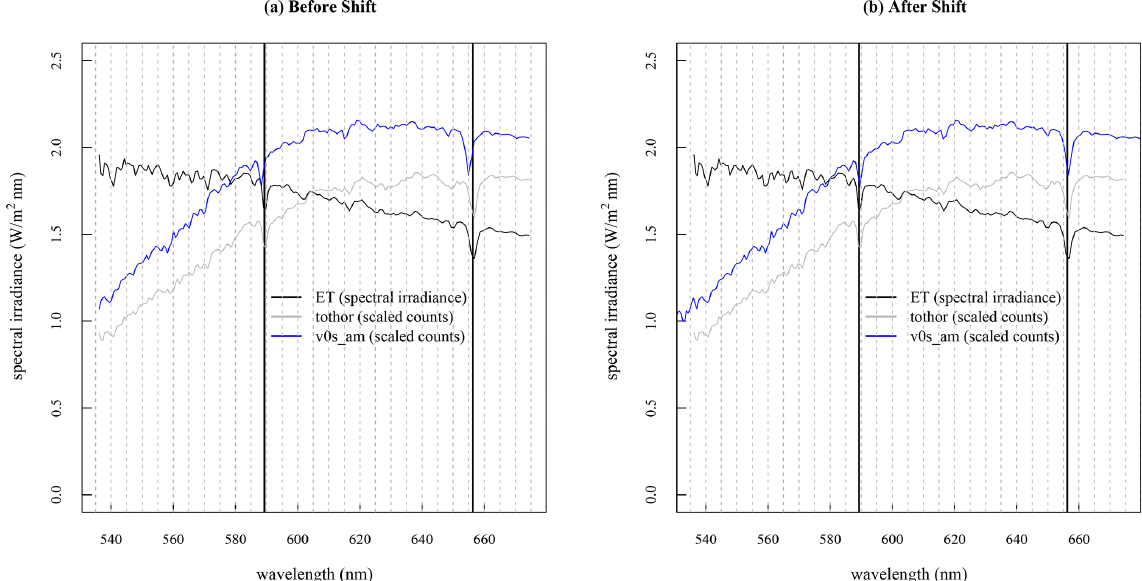
Figure 2. The average of nine spectra near solar noon appears as the blue line; the extraterrestrial spectrum (ET) at RSS resolution is the black line (units on the y axis refer to the ET), and the gray line is the carefully determined spectrum used as the standard total horizontal spectrum that is compared to all RSS data. The blue spectrum in panel (a) is shifted shortward by 2pixels, and panel (b) shows the shift-corrected spectrum. The two absorption lines are in the solar spectrum since they also appear in the ET spectrum; these are the sodium doublet line 589.0/589.6nm and the hydrogen alpha line